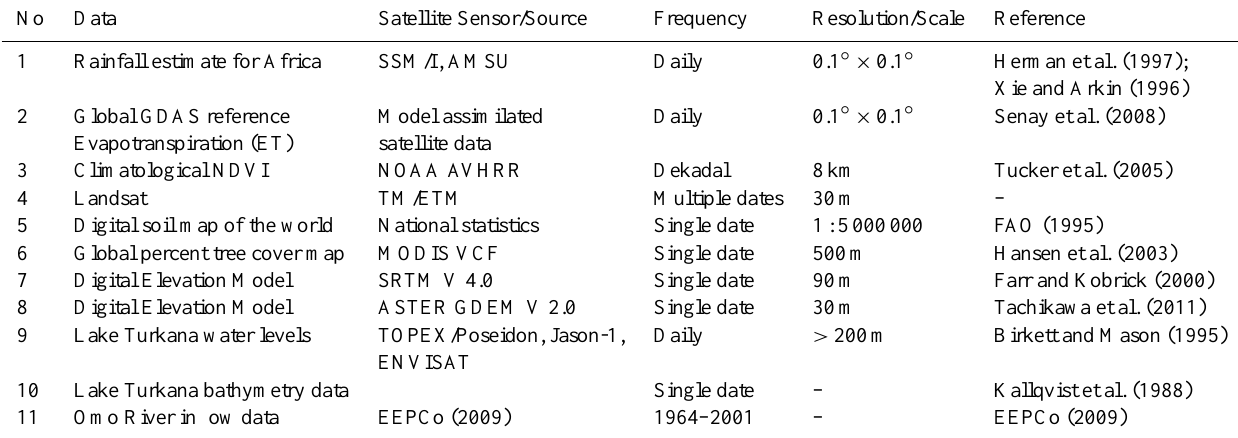
Table 1. Satellite data, products, and other ancillary data used in this